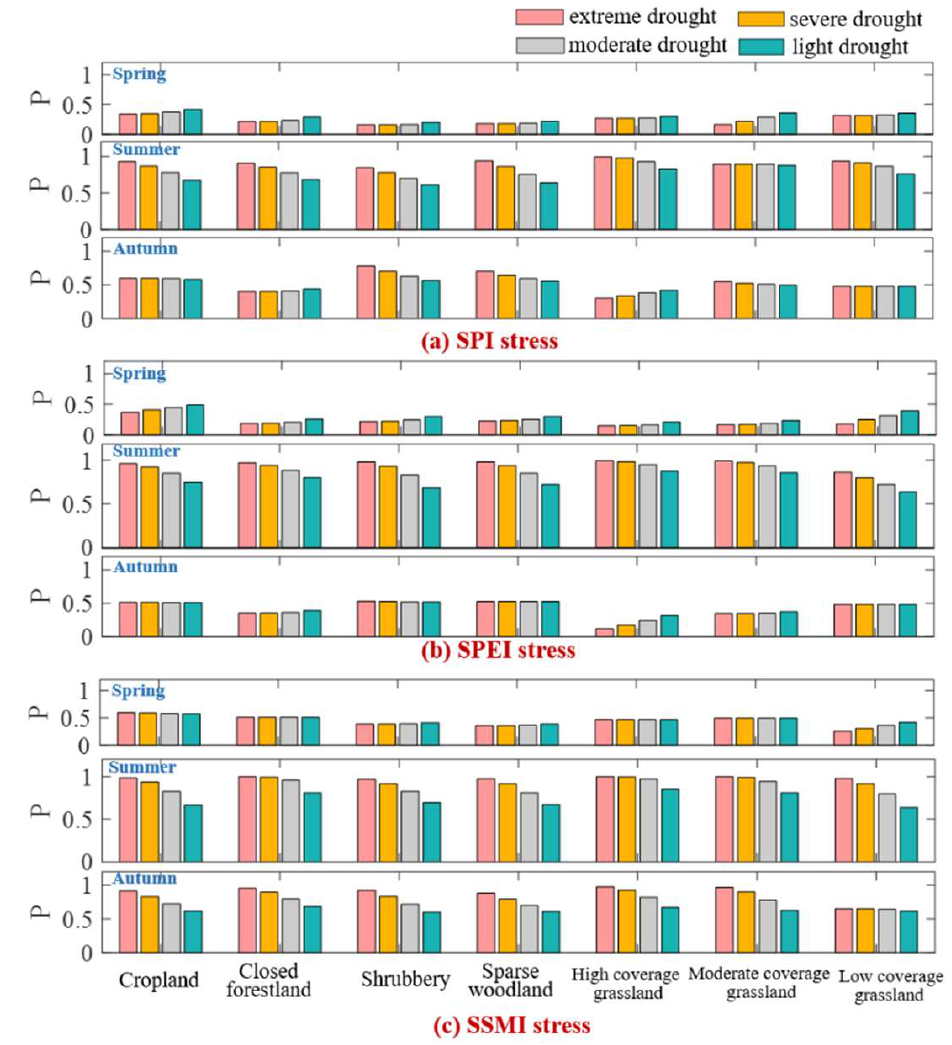
Figure 6. The conditional probability of NDVI vulnerability of seven vegetation types under SPI stress ( a ), SPEI stress ( b ) and SSMI stress ( c ). Table 2. Dominant drought stress factors of vegetation